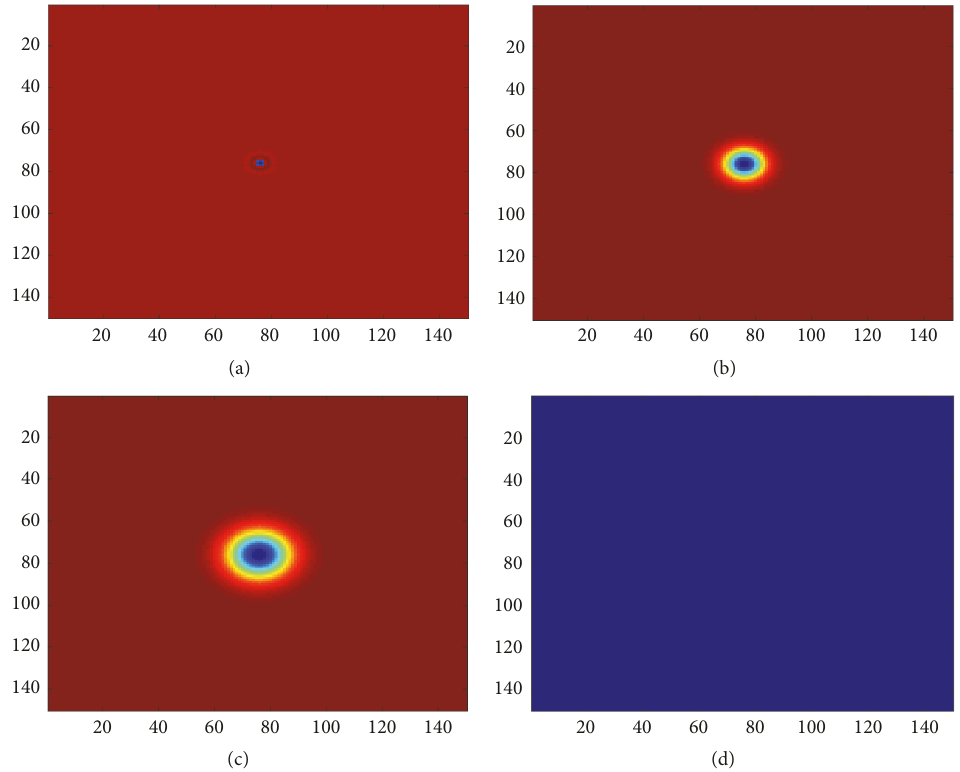
Figure 14: The snapshots of spatial distribution of membrane potential with color scale for neurons in the square array network for 𝑘 = 1.5 and 𝐷 = 5 at (a) 𝑡 = 2 time units, (b) 𝑡 = 75 time units, (c) 𝑡 = 135 time units, and (d) 𝑡 = 300 time